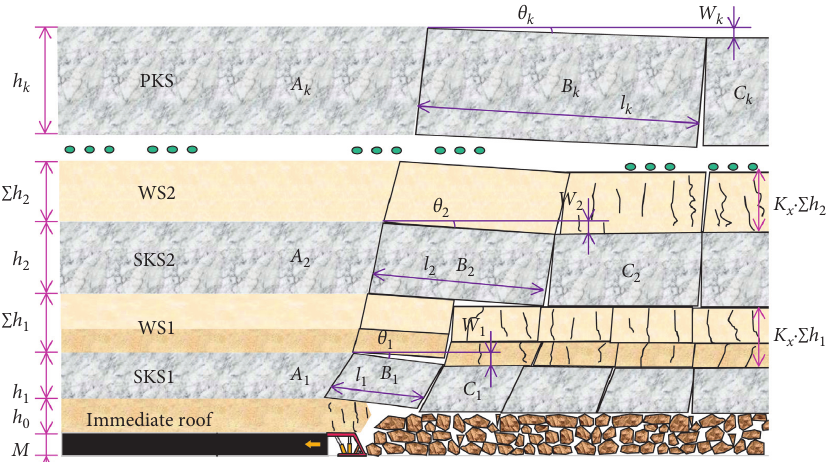
Figure 4: Roof model of a stope with a multikey stratum